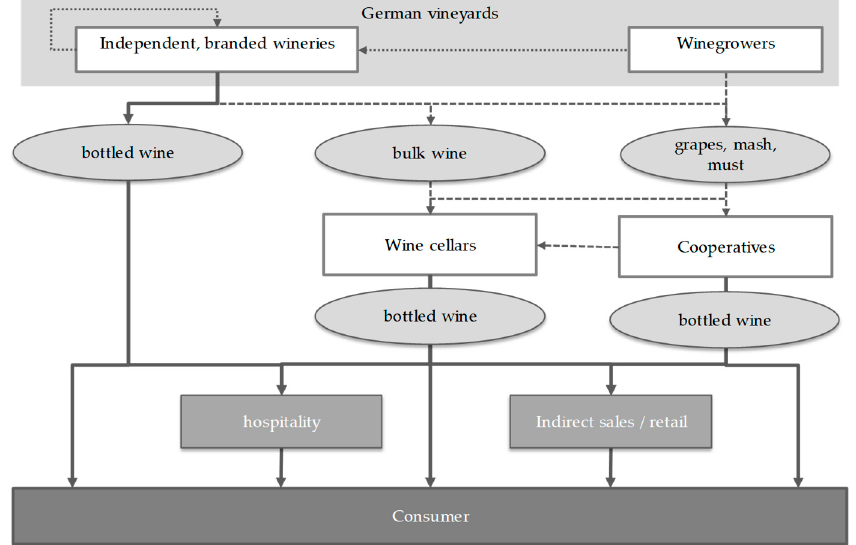
Figure 4. German wine supply (author’s illustration).